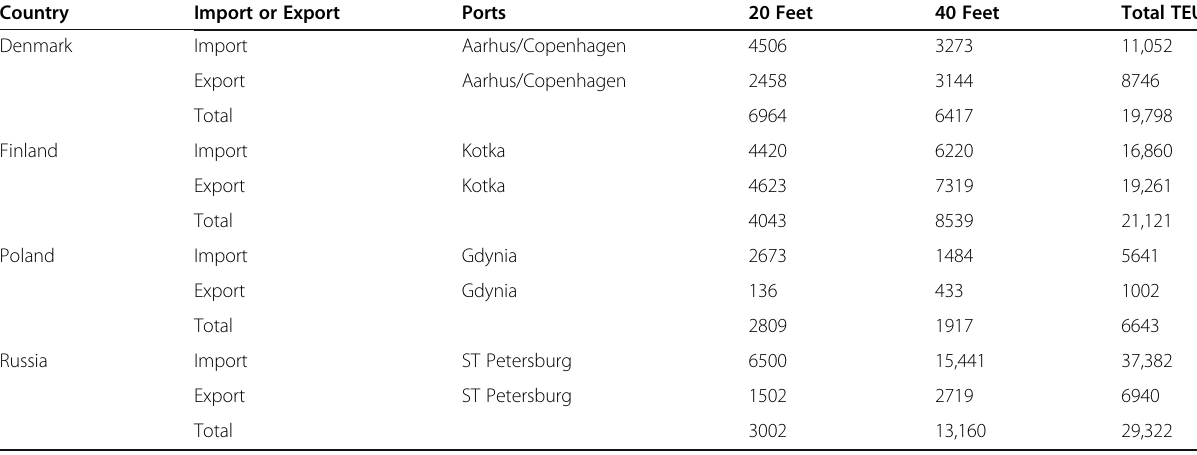
Table 1 Cargo Volume Transported by Company A for year 2018. (Source: authors) Country Import or Export